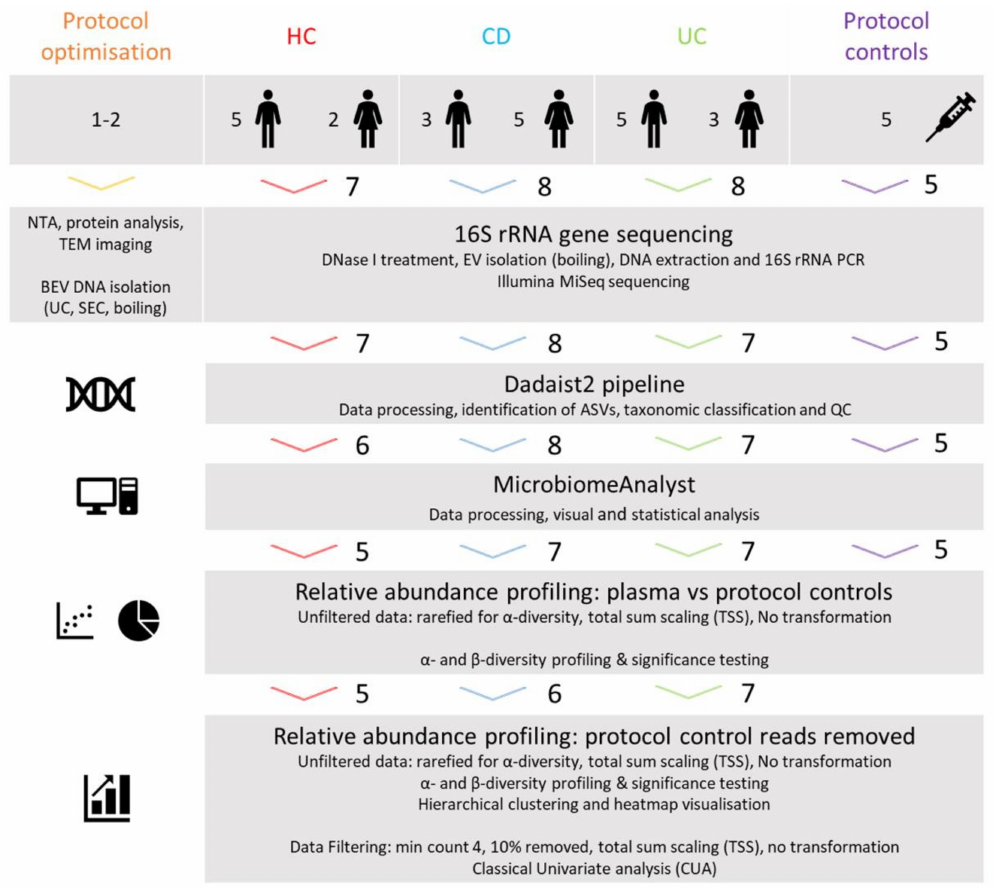
Figure 1. Study design overview. To characterize the BEV profile in HC and IBD plasma, archived samples from a cohort of healthy individuals (seven HC) and patients diagnosed with IBD (eight CD and UC) were utilized alongside five control samples representing each stage of the protocol. Two further HC samples were characterized and processed for protocol optimization. Samples were analyzed for 16S rRNA gene sequencing and data processed using the Dadaist2 pipeline. The processed data was analyzed using the MicrobiomeAnalyst web platform and evaluated using taxonomic profiling and significance testing. Healthy controls (HC), Crohn’s disease (CD), and ulcerative colitis (UC). The number of samples used at each stage of the study are